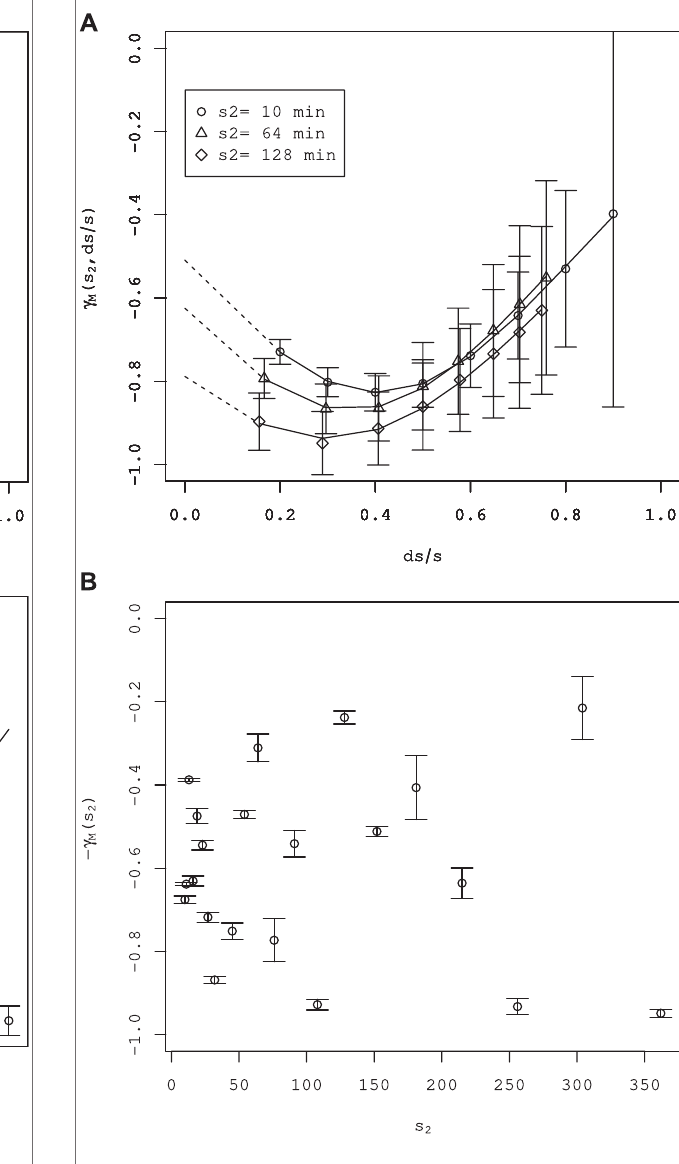
FIGURE 5 | Estimation of the parameter c M . (A) The parameter ( s , ds / s ) obtained by the regressions shown in Figure 3 and nonlinear c M fi tting log ( c ( s )) (cid:2) a + b ( ds / s ) + c ( ds /s ) 2 . The standard errors of regression M Eq. 28 are denoted by an error bar. (B) c M ( s ) (cid:2) exp ( a ) (see the text). Standard errors of nonlinear fi ttings are denoted by an error bar.